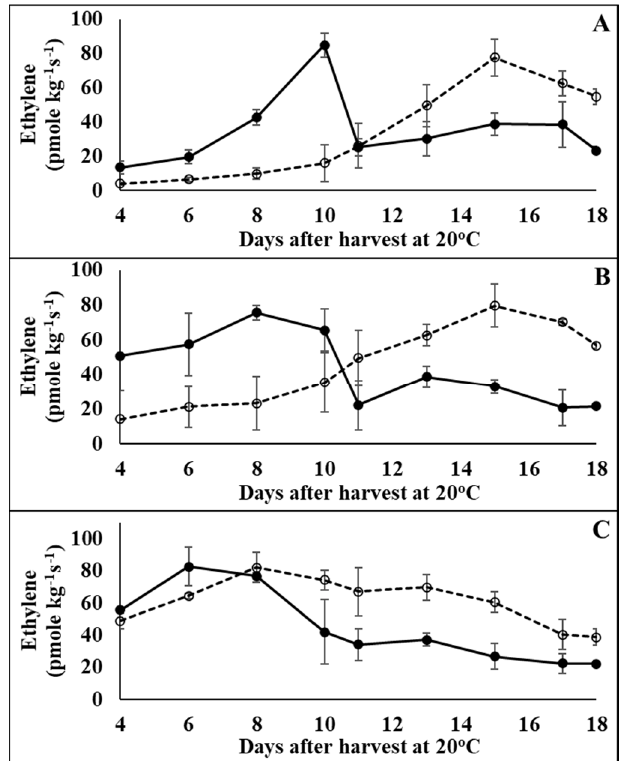
Figure 2. Ethylene production rate of 1-MCP treated and untreated tomatoes (control) after harvest at different maturity stages. ( A ) Mature green, ( B ) Breaker, ( C ) Early orange. Full lines—Untreated tomatoes, broken lines- 1-MCP treated tomatoes. Values are mean ± SE bars ( n = 3).